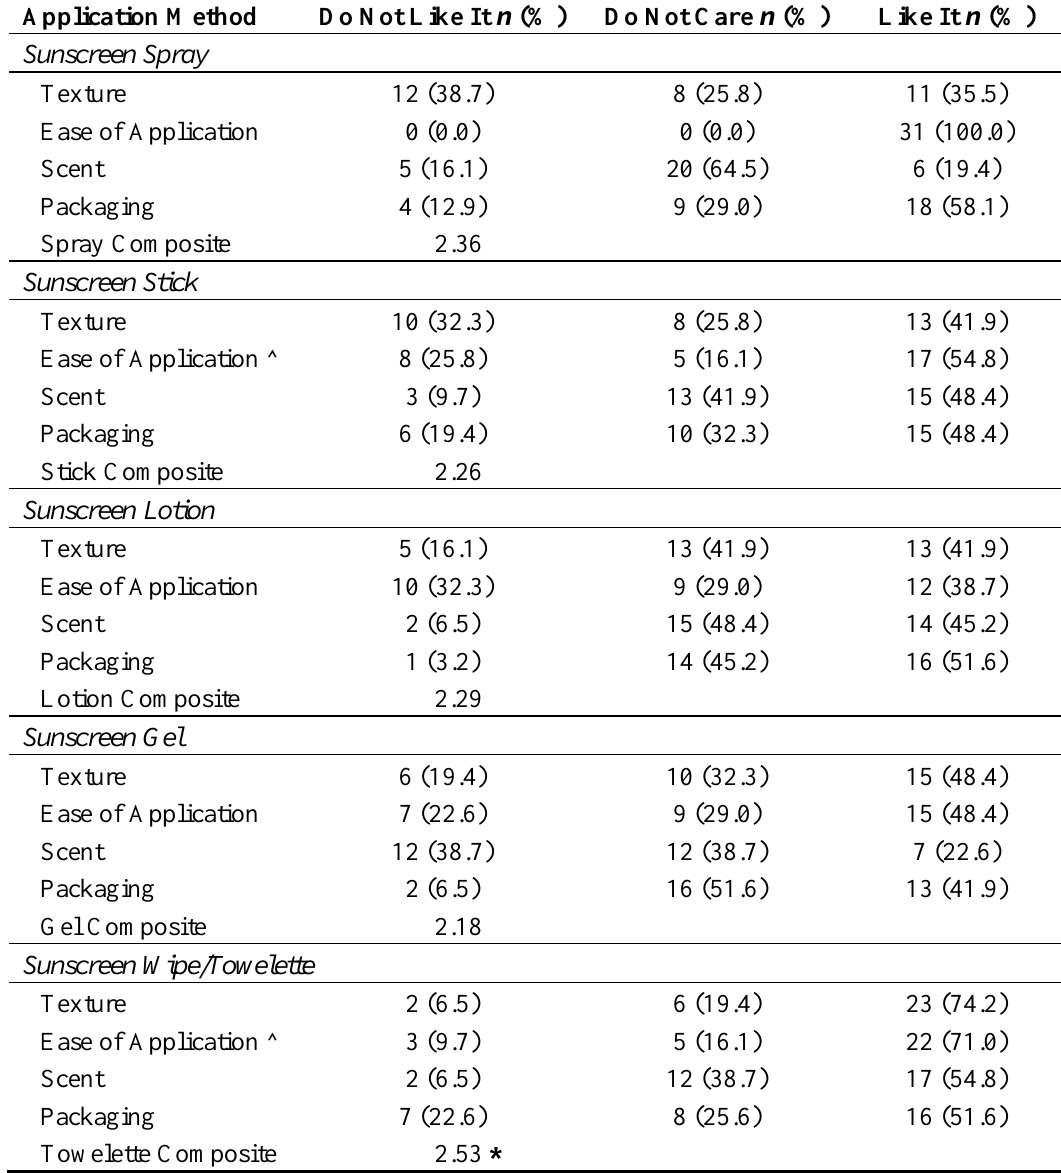
Table 7. Comparison of Sunscreen Application Methods ( n = 31).